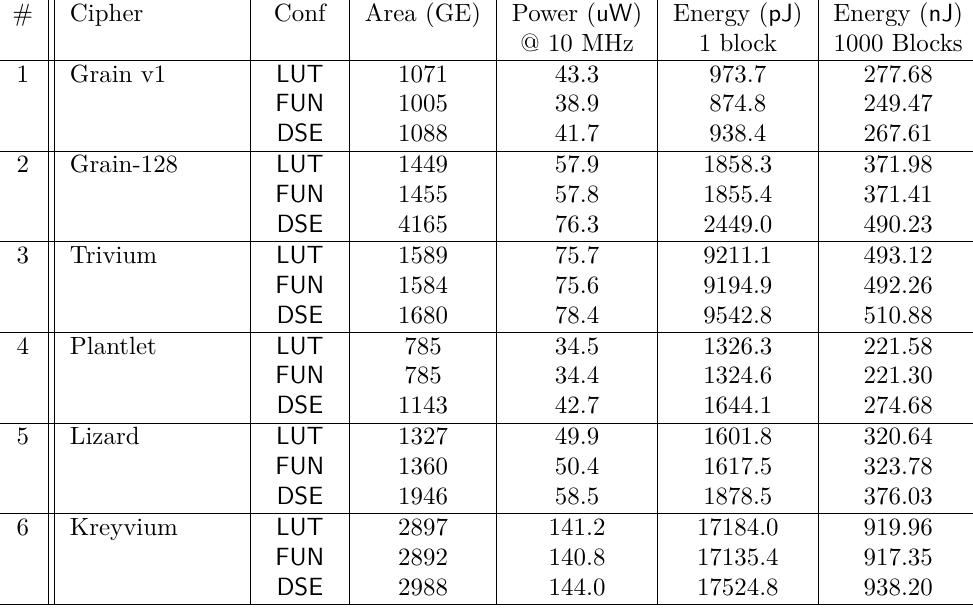
Table 3: Results for different realizations of the round functions. LUT : Lookup table, FUN : Functional synthesis using Synopsys tool, DSE : DSE